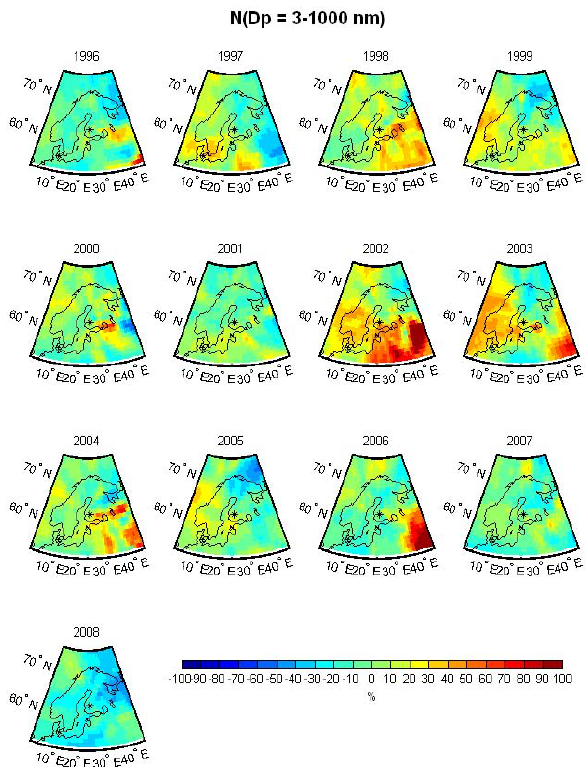
Fig. 5. Deviation from measured average number concentration of total number concentration of particles ( D p = 3–1000nm) in Hyyti¨al¨a according to transport directions. Yearly concentration fields are produced for years 1996–2008. Fields are normalized to the geometric mean concentration (1707 cm − 1 ) of the whole mea- surement period. Hyyti¨al¨a is marked with a star.